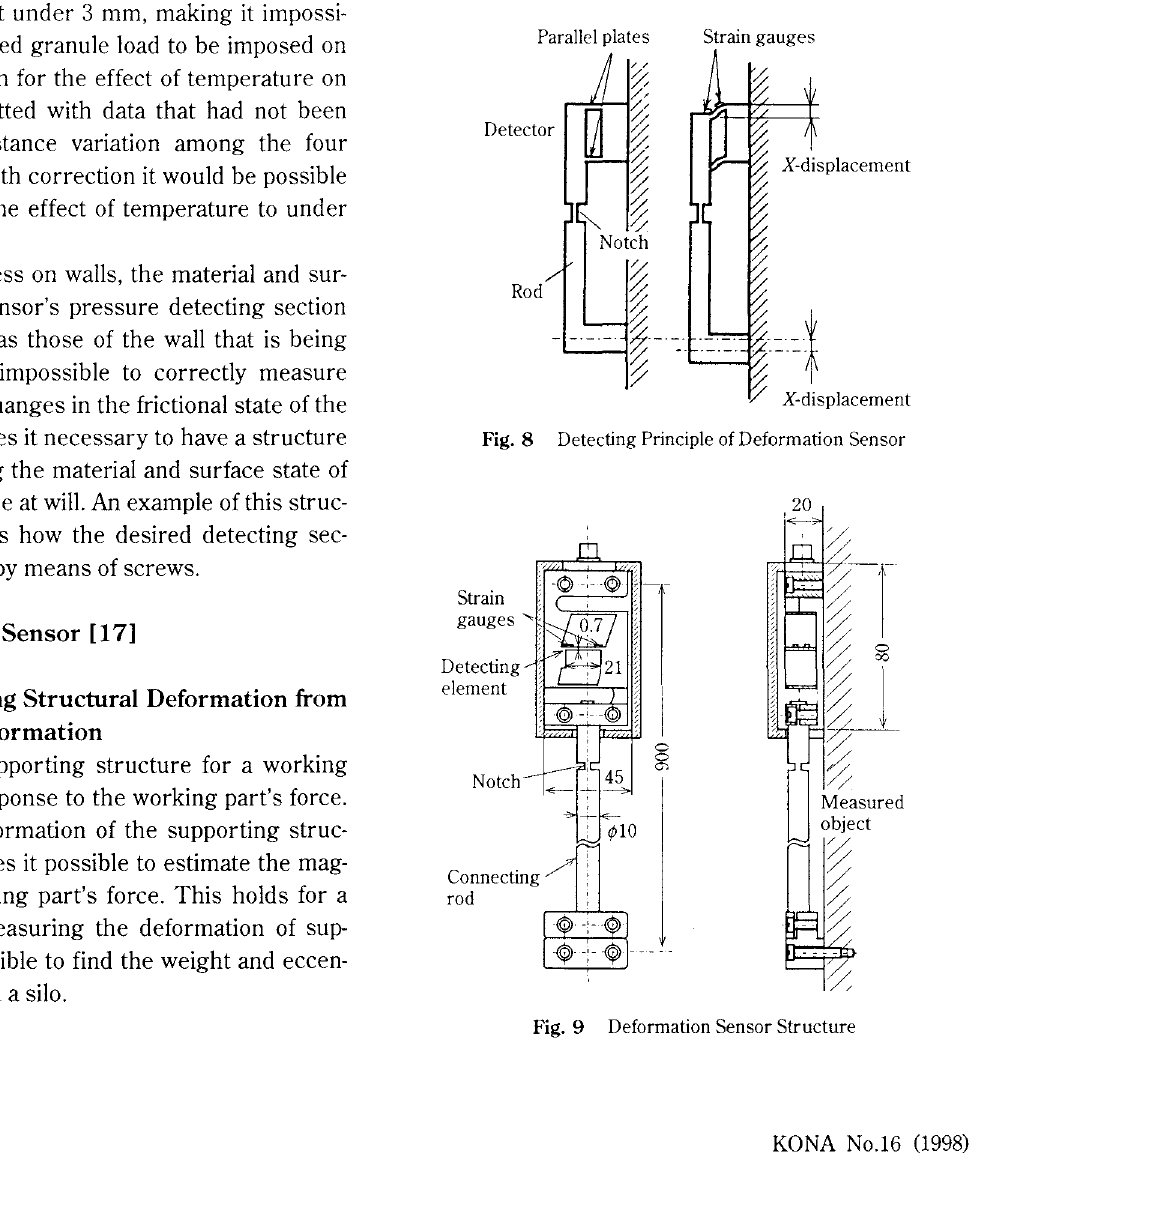
Fig. 9 Deformation Sensor